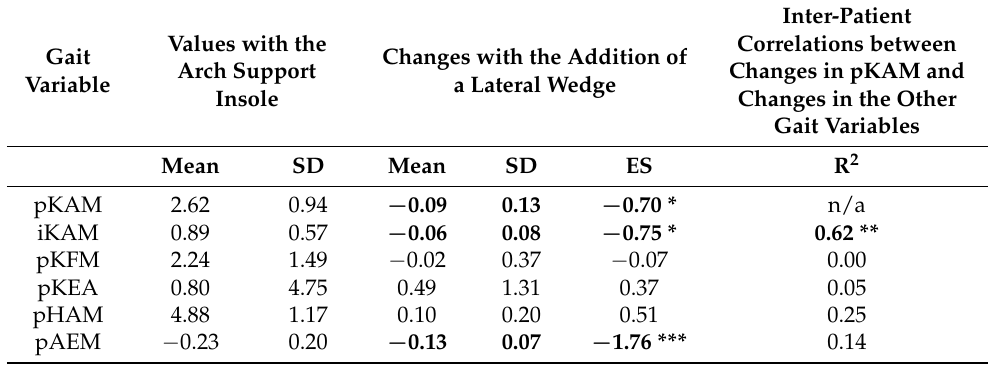
Figure 2. Intra-patient relationships between changes in pKAM and changes in iKAM, pKFM, pKEA, pHAM, and pAEM for a typical patient (#9). Each dot corresponds to a walking trial and the lines to the linear regressions. * p ≤ 0.05, *** p ≤ 0.001. Table 3. Gait changes observed for the group of 10 patients, with the addition of a lateral